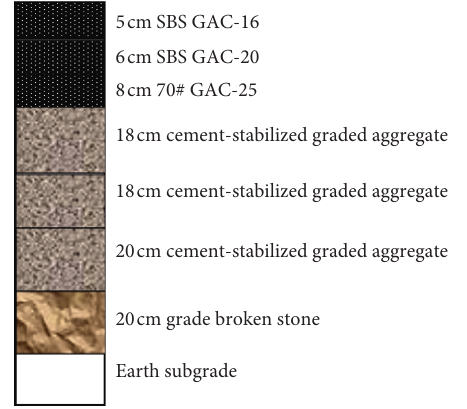
Figure 1: Pavement structure of the test section.